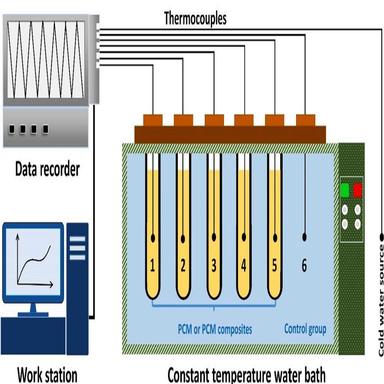
Experimental set-up for testing thermal storage/release rate behavior.